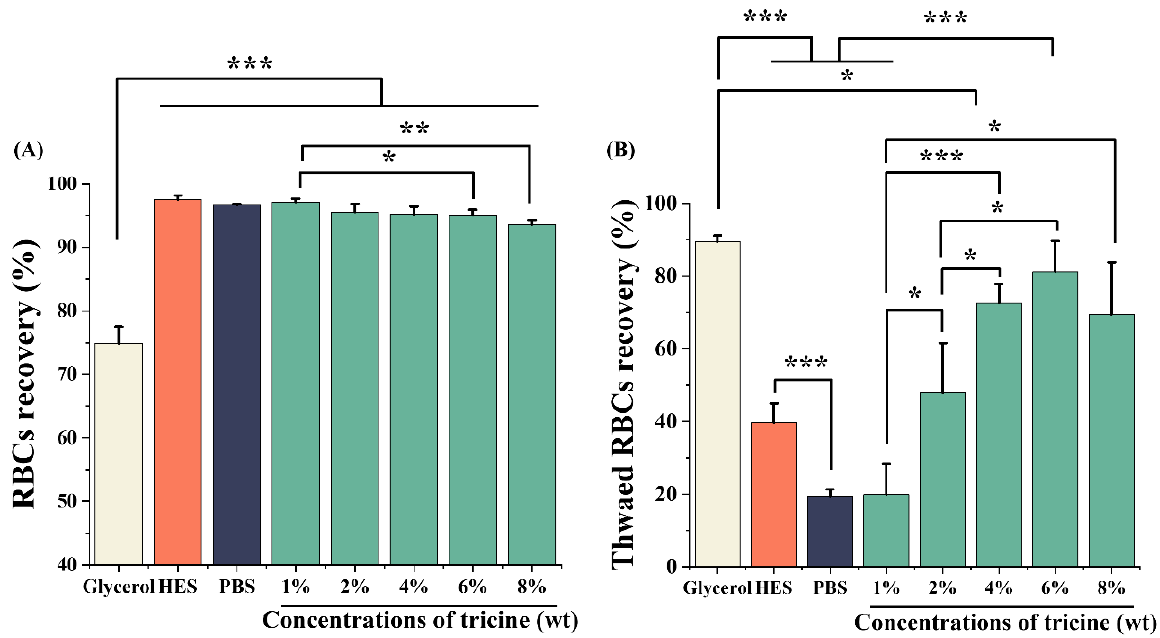
Figure 2. The biocompatibility ( A ) and thawed RBCs’ recovery ( B ). The concentrations of glycerol and HES were 20% and 13%, respectively. * p < 0.05; ** p < 0.01; *** p <